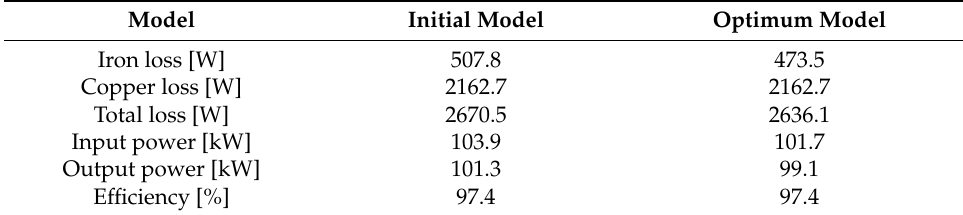
Table 7. Power characteristics of the initial model and optimum model.